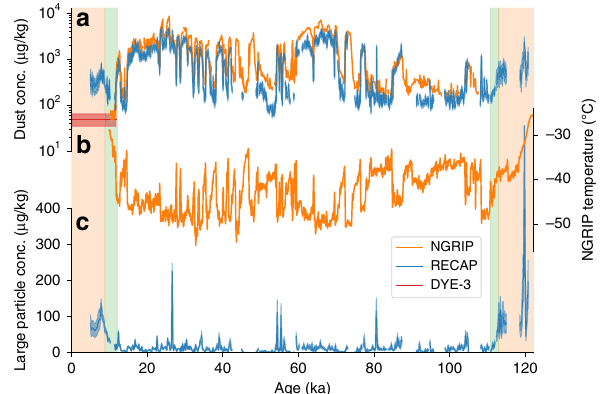
Fig. 1 Dust and temperature records from Greenland ice cores. a The total concentration of dust particles in the size range 1.25 – 10.5 μ m in the RECAP and NGRIP ice cores over a full glacial cycle on 50 year resolution. For DYE- 3 the plot shows the average Holocene value. The coloured shadings around the curves are 1 σ errors. b NGRIP temperature reconstructed from atmospheric nitrogen isotope ratios 21 . c The large (8.13 – 10.5 μ m) particle concentration in the RECAP ice core on 200 year resolution. The background colours indicate periods of high (orange) and low (white) large particle concentrations and the transition between the two states (green), determined by a piecewise continuous ramp fi t